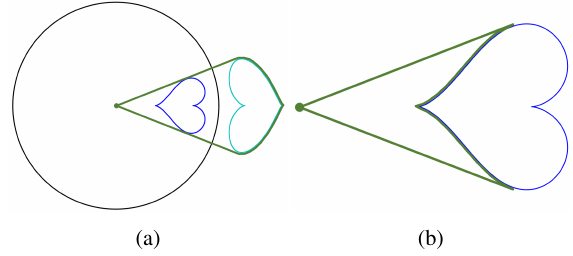
Figure 5: A 2 D example is given to illustrate the algorithm in [Katz et al., 2007] for computing visibility of point cloud. The blue heart represents a point cloud and the view point is in the center of the circle. The blue heart is transformed to the cyan dis- torted one as Equation 4. A convex hull of the transformed heart and the view point is computed, and the visible part of the blue heart exactly corresponds the hull boundary as shown in (b). In reality the circle is much larger than the displayed one.